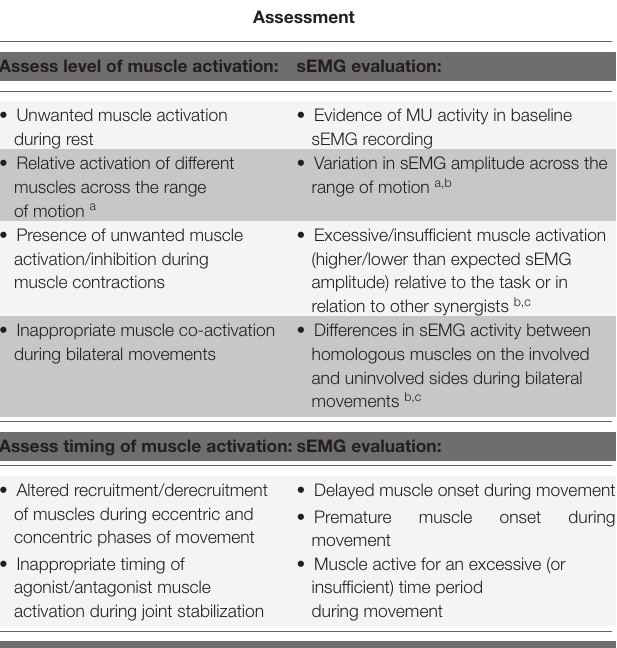
TABLE 1 | Examples of sEMG applications in assessment and treatment, see Chapter 10 in Criswell (4).